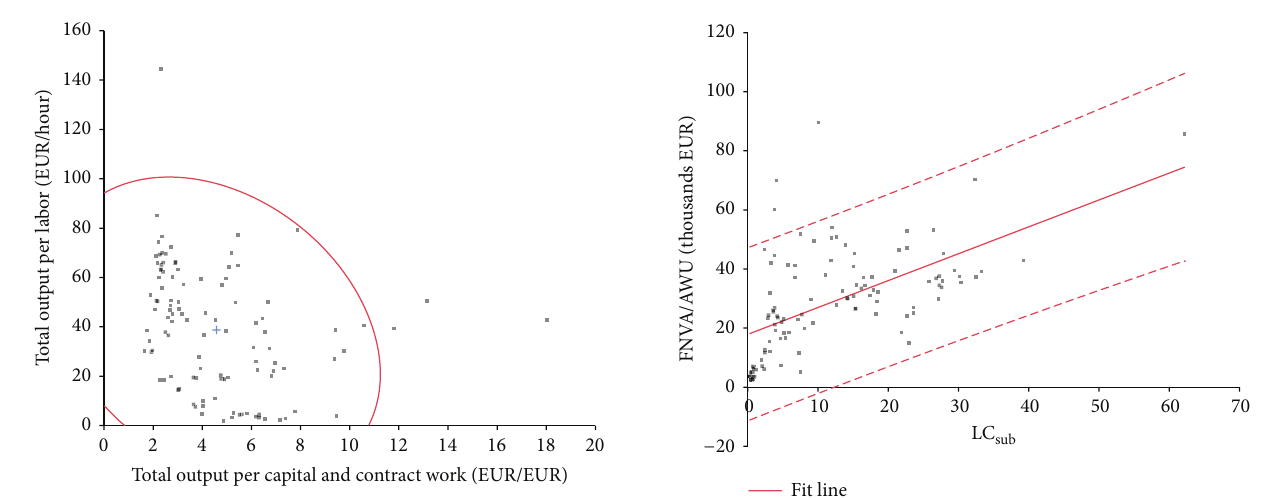
Figure 2: Regression line.